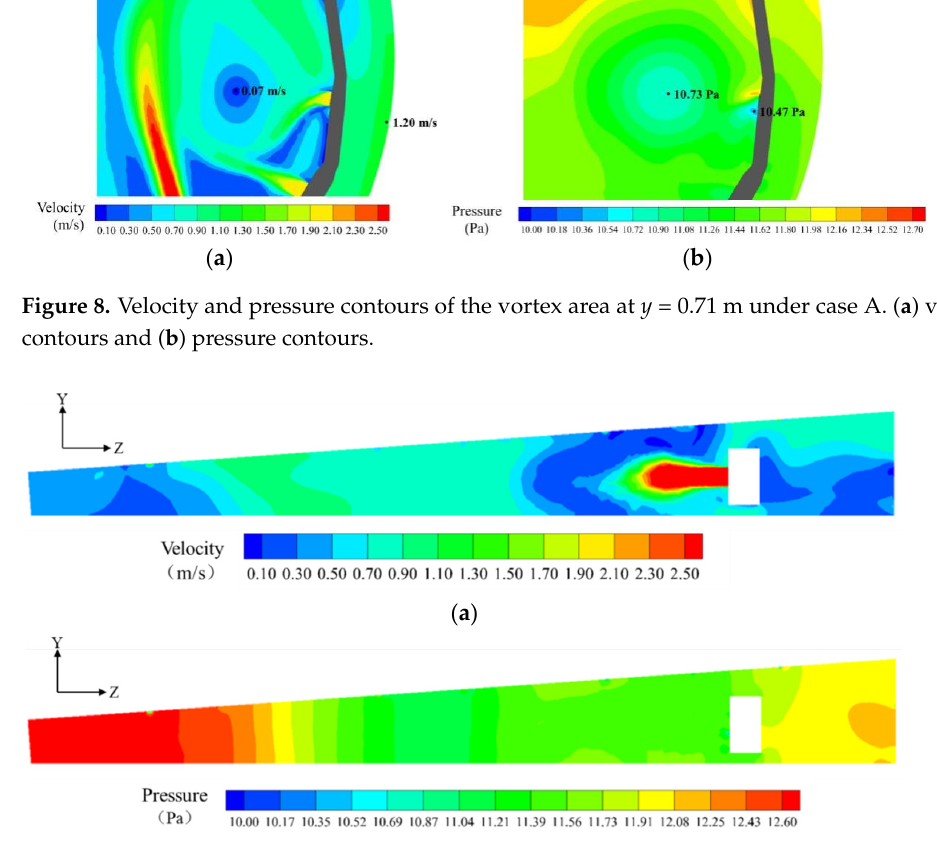
Figure 9. Velocity and pressure contours of plenum at x = 7.62 m under case A. ( a ) velocity contours, ( b ) static pressure contours.